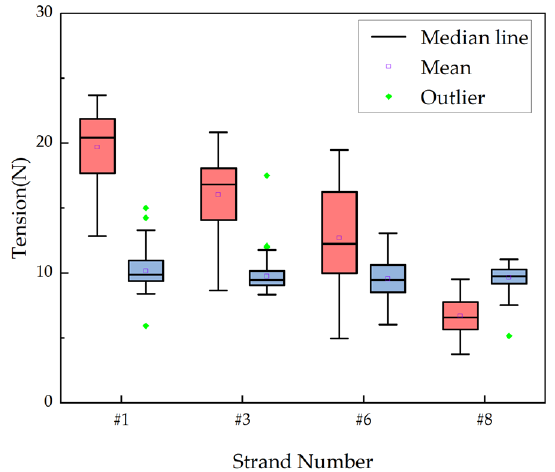
Figure 12. Box plot comparing tension of each strand before and after control Figure 1 2. Box plot comparing tension of each strand before and after control intervention.